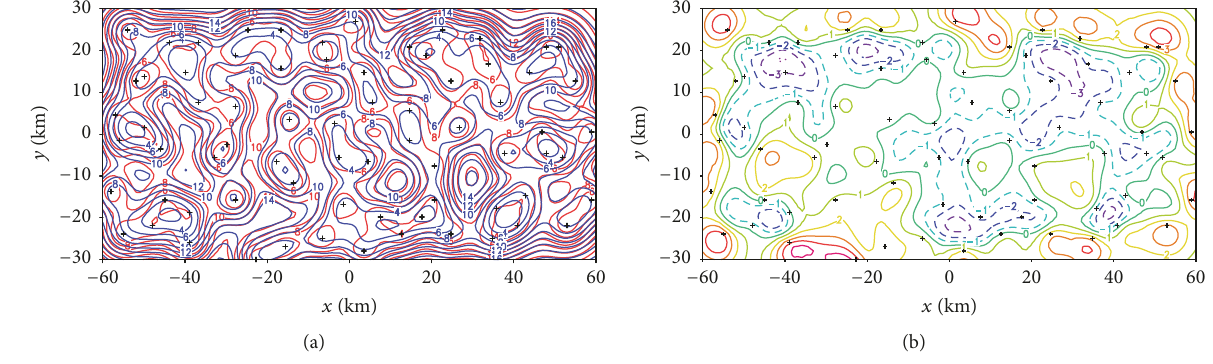
Figure 12: As in Figure 11 but without periodic